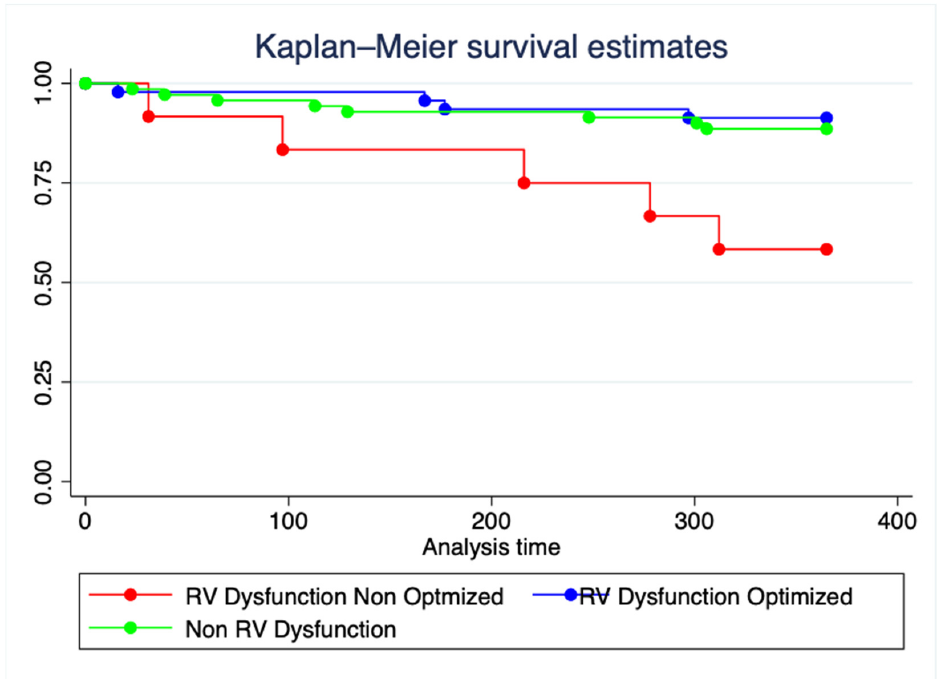
Figure 2. One-year all-cause mortality according to preimplantation RV hemodynamics. Cox re- gression model adjusted by age, type of cardiomyopathy, INTERMACS, creatinine, total bilirubin, and albumin.